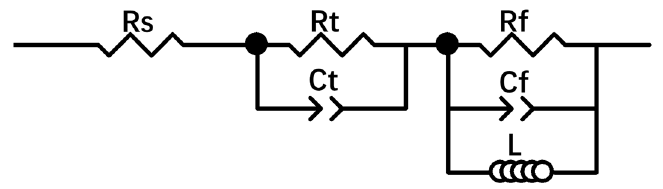
Figure 13. Equivalent electric circuit diagrams of EIS from Figure 12.